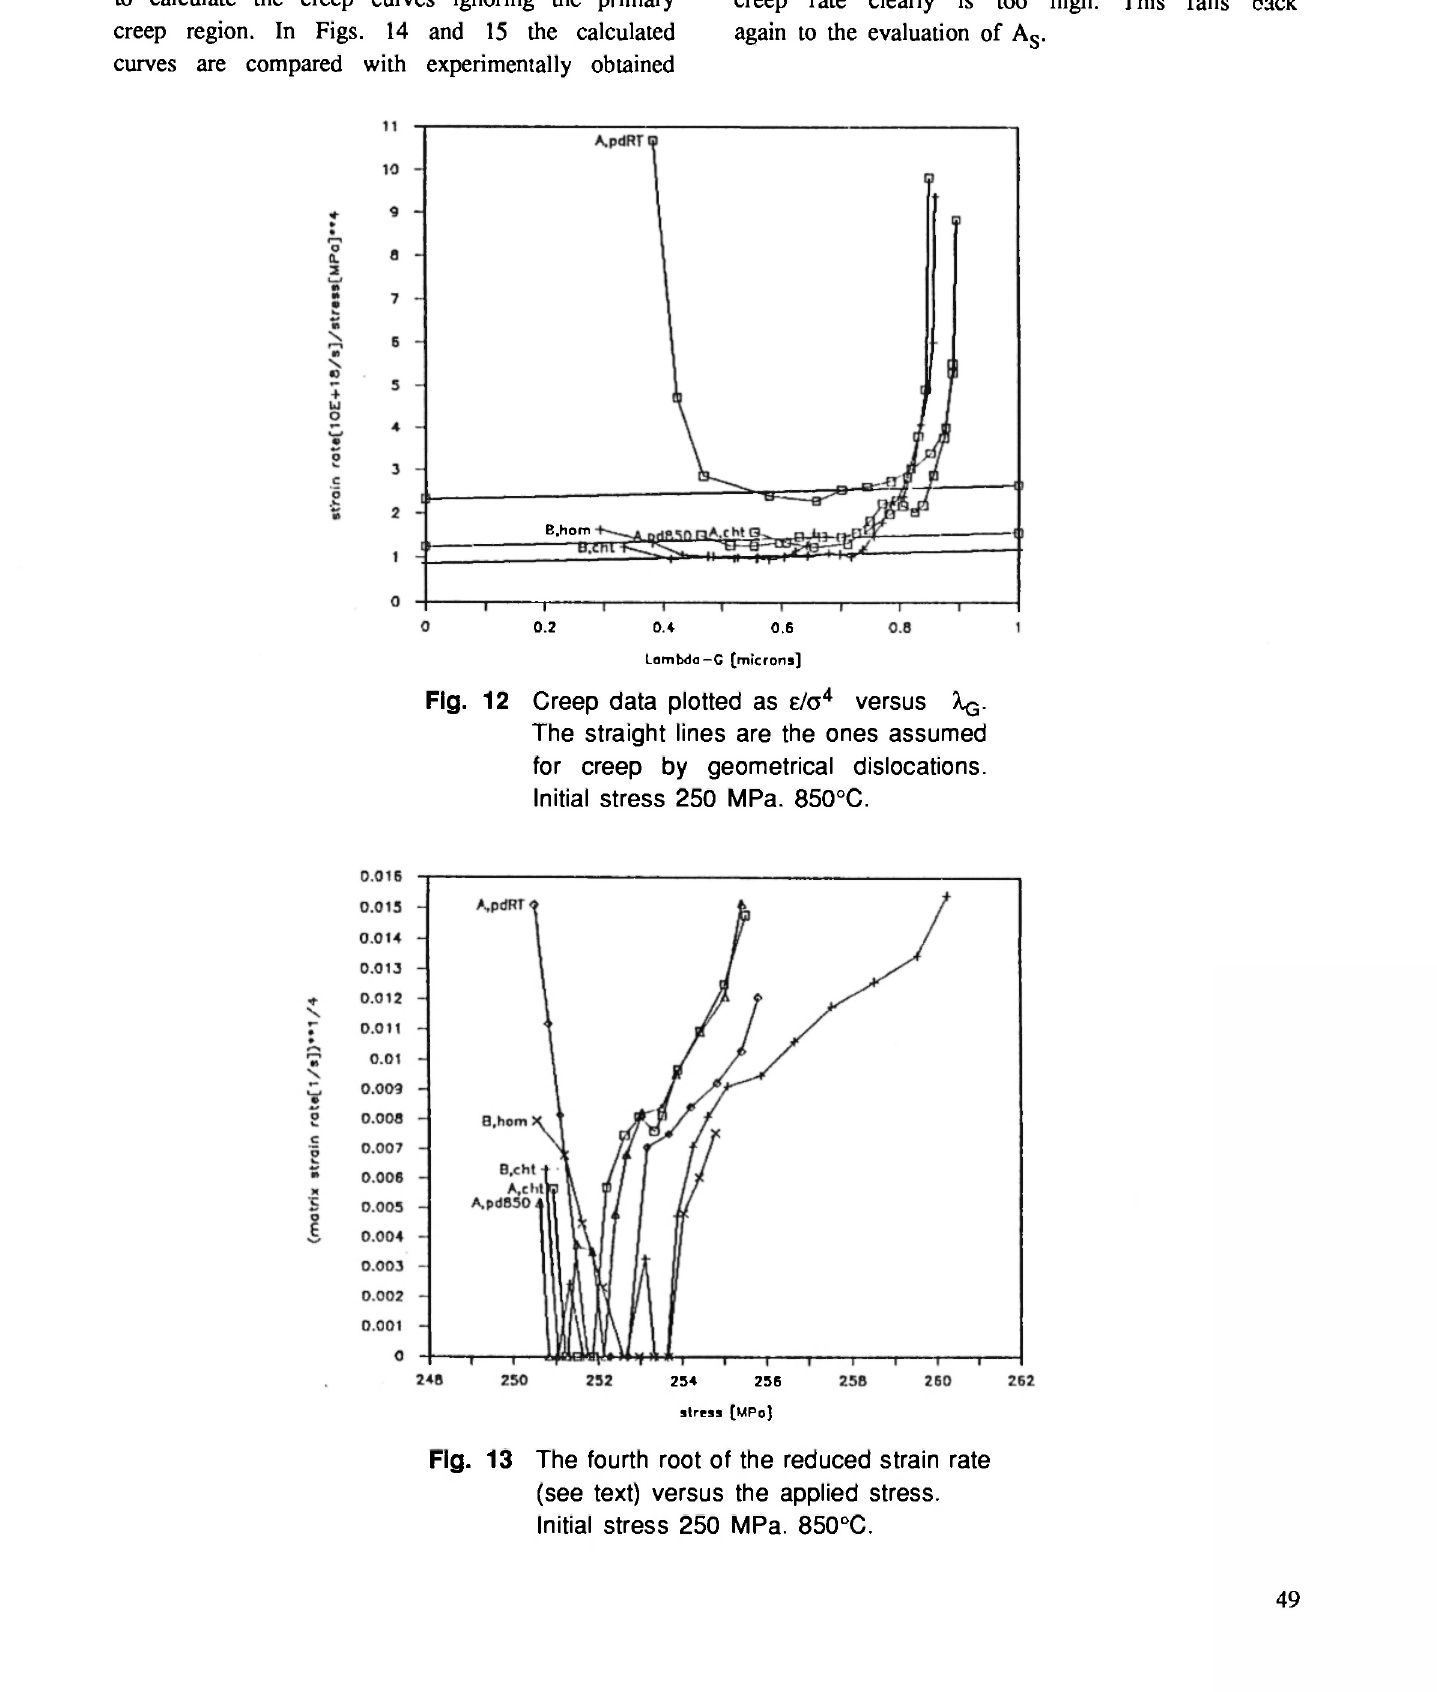
Fig. 12 Creep data plotted as ε /σ 4 versus λ^. The straight lines are the ones assumed for creep by geometrical dislocations.